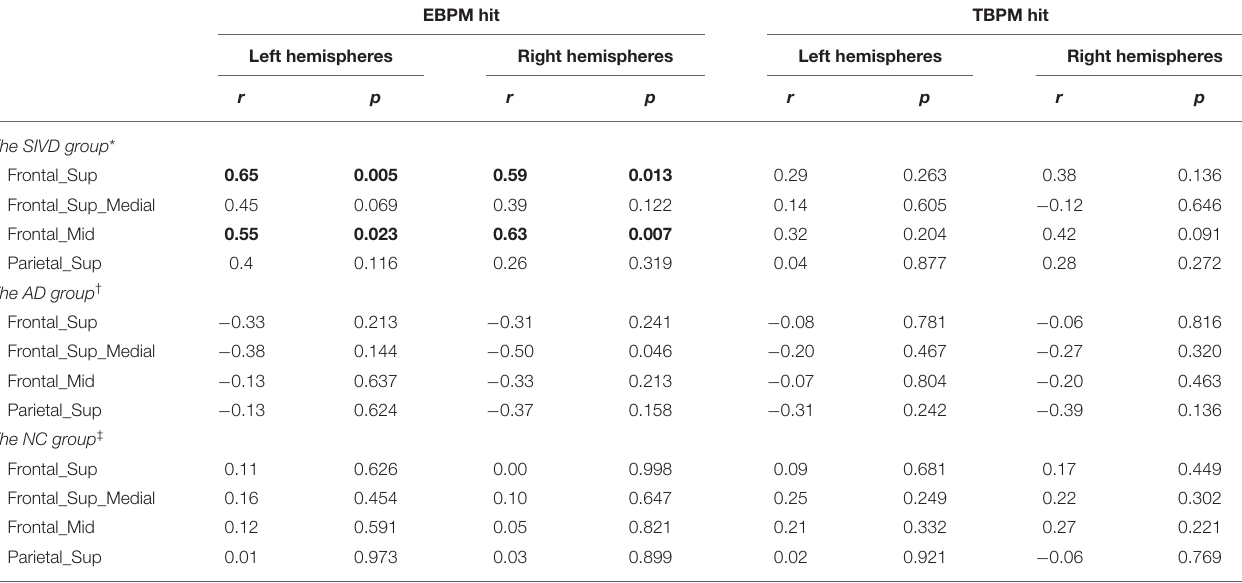
TABLE 3 | Partial correlation between PM performance and ReHo in ROIs controlling for confounding variables. EBPM hit TBPM hit Left hemispheres Right hemispheres Left hemispheres Right